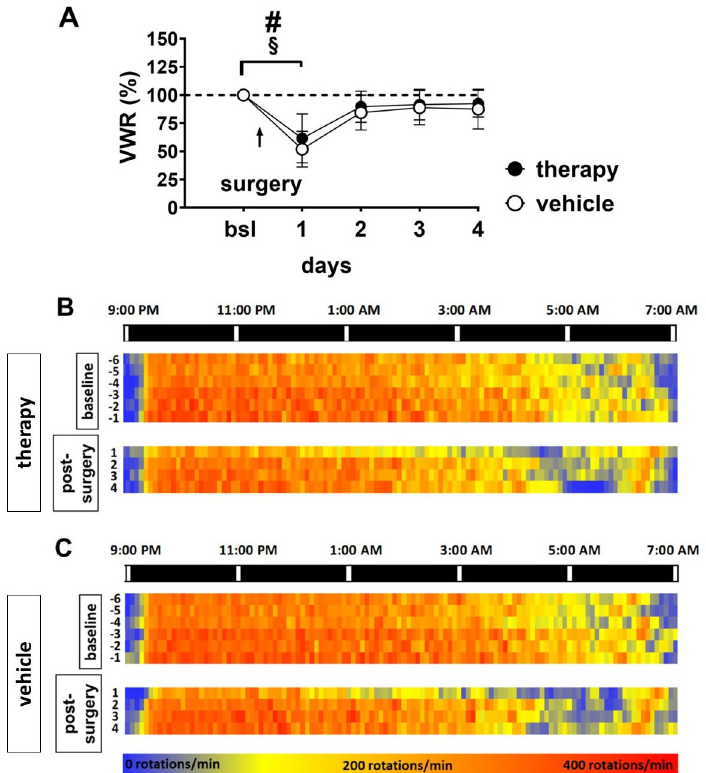
Fig 3. Activity patterns of baseline and post-surgical recovery phase. VWR activity dropped to 62% of baseline in the therapy and 52% in the vehicle group on day 1, followed by an increase to ~90% and ~84%, respectively, on day 2 (A; # = therapy group: linear mixed-effects model, fixed effects type III: p < 0.0001, F (3.988, 35.90) = 13.12; Dunnett’s multiple comparisons test p = 0.0055; § = vehicle group: linear mixed-effects model, fixed effects type III: p < 0.0092, F (3.922, 32.12) = 4.068, Dunnett’s multiple comparisons test p = 0.0001). The heat map (B,C) presents the VWR activity data displayed in 5-minute intervals during night-time for days of baseline (day -6 to -1) and post-surgery phase (day1 to 4). This is shown separately for the therapy group (3B) and the vehicle group (3C). Each line represents one dark phase (9 PM-7 AM). For each day, the values of 5-minute intervals are summarized for each group and colour-coded with blue representing low and red representing high VWR activity (0–400 rotations/min). Comparing baseline activity to post-surgical activity a marked reduction can be observed primarily in the second half of the dark phase in both